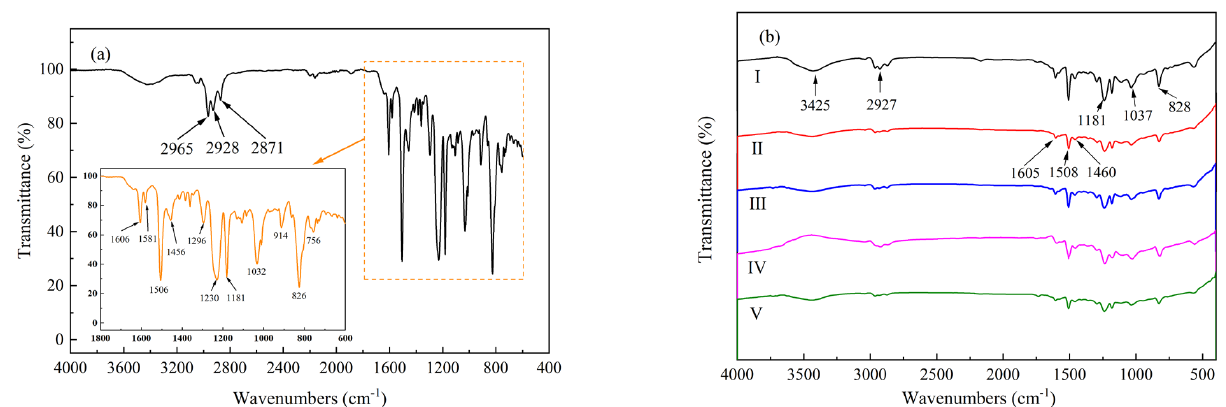
Figure 5. FT − IR patterns for ( a ) uncured prepreg and ( b ) laminates cured by various procedures: I conventional oven-cured sample, II M1, III M2, IV M3, and V M4.